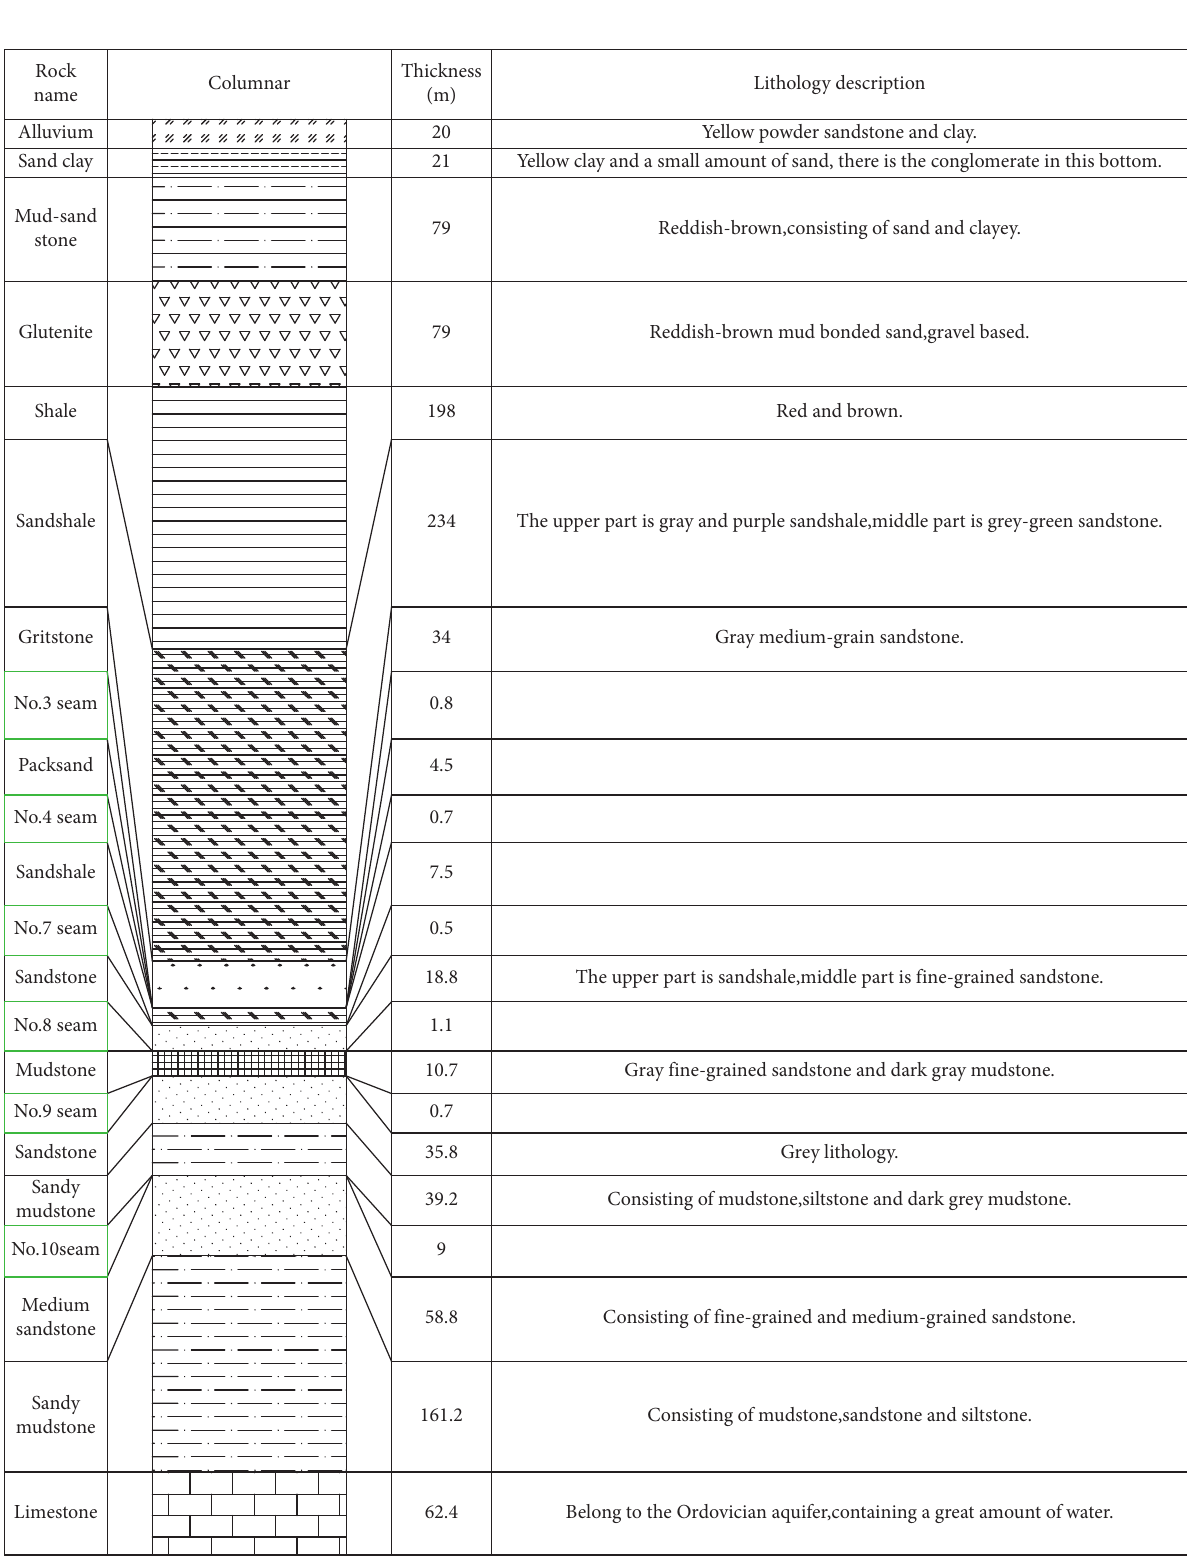
Figure 2: Generalized stratigraphic column of Haizi Coal